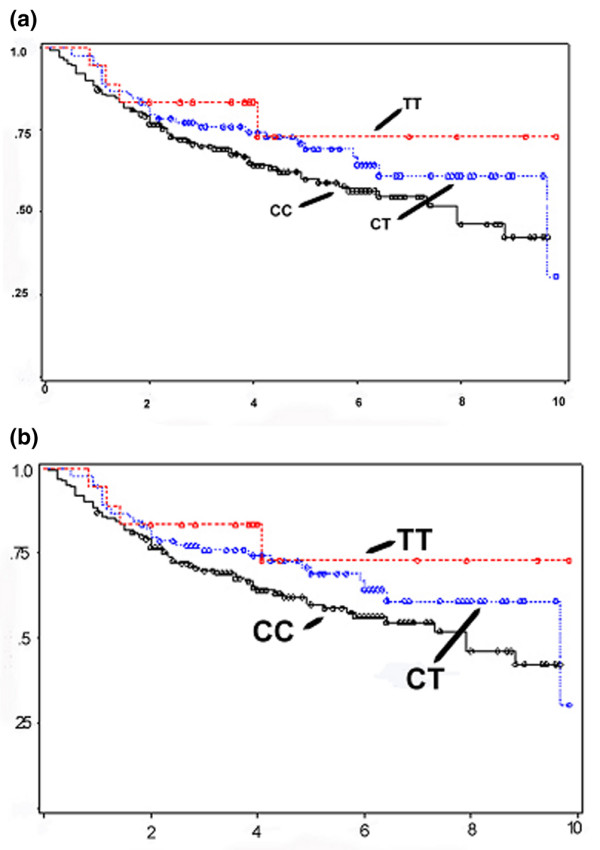
(a) Percentage overall survival and (b) percentage recurrence-free survival by years of follow-up in the manganese superoxide dismutase -102 genotype. CC, homozygous wild-type genotype; CT, heterozygous for variant genotype; TT, homozygous variant genotype.